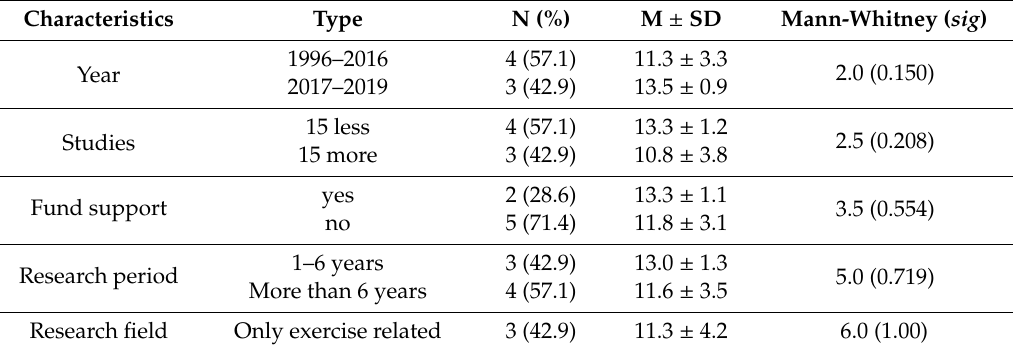
Table 8. Di ff erences in the AMSTAR 2 quality score according to research